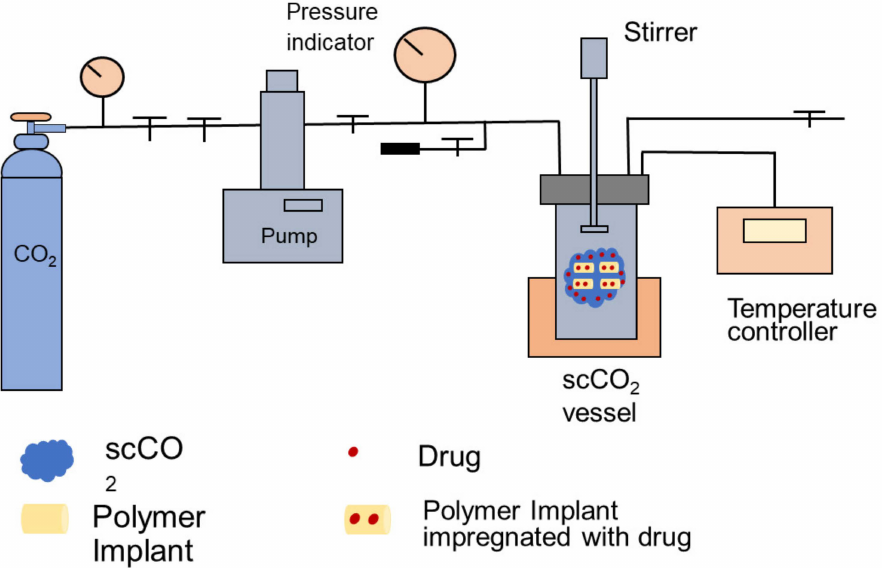
Figure 9. Schematic illustration of the supercritical CO 2 method. The drug of interest is dissolved in scCO 2 and impregnated into the polymer, and the non-impregnated drug is removed with CO 2 through depressurization. (Adapted from Xu., et al. Drug Delivery and Translation Research , 2021